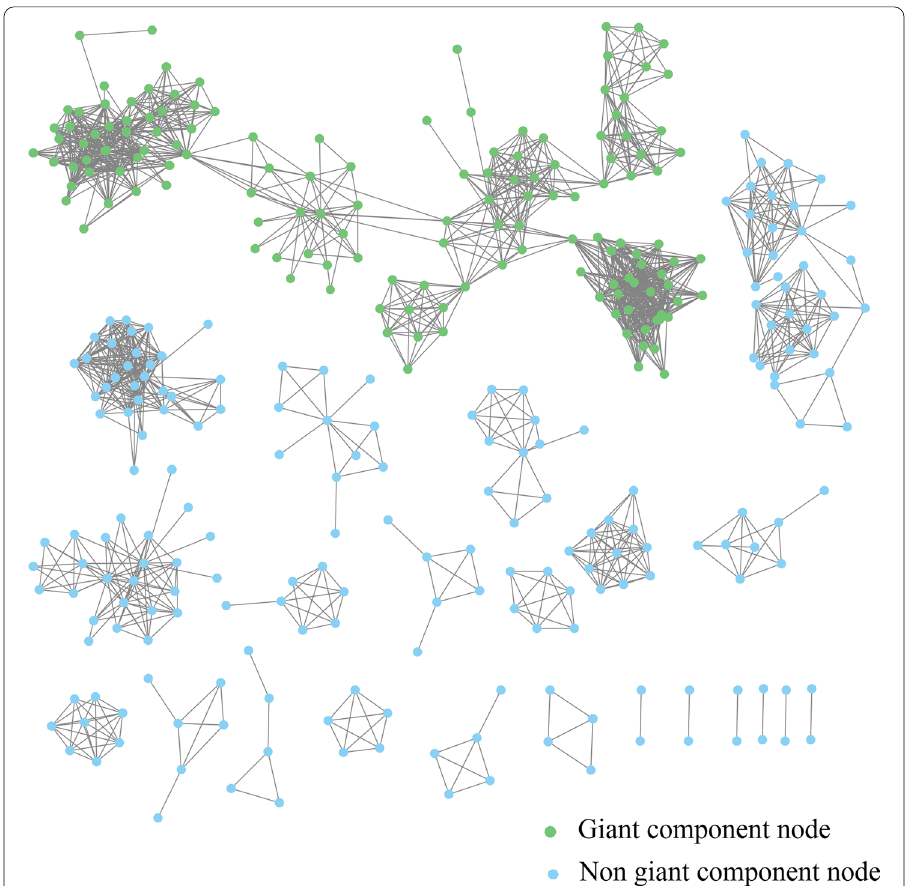
Fig. 3 Network formation using Cytoscape. Each node represents a disease, and the link represents a similar relationship between diseases. There is a giant component, with the number of nodes